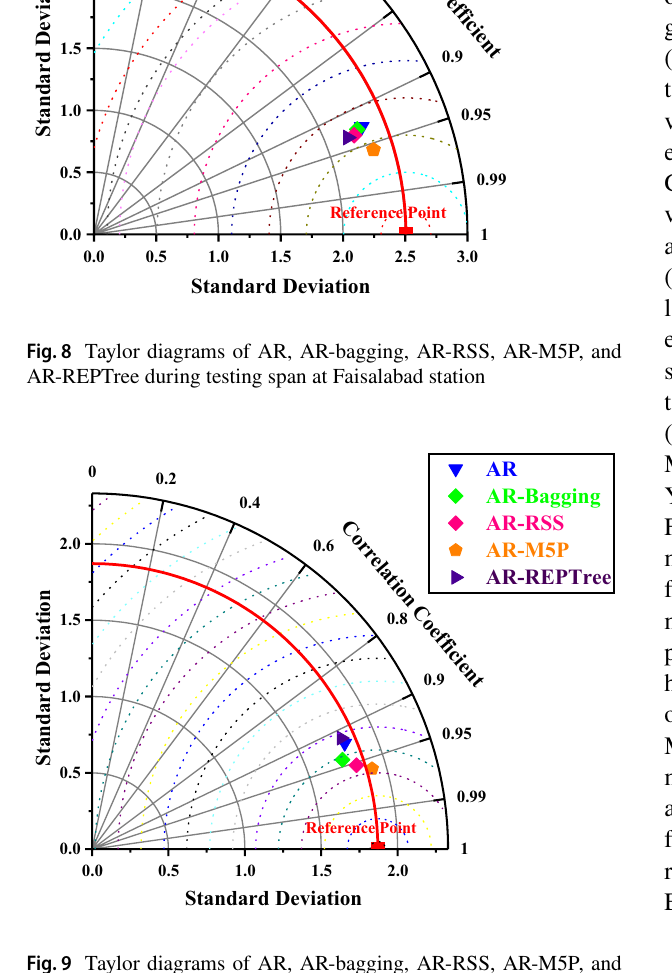
Fig. 9 Taylor diagrams of AR, AR-bagging, AR-RSS, AR-M5P, and AR-REPTree during testing span at Islamabad